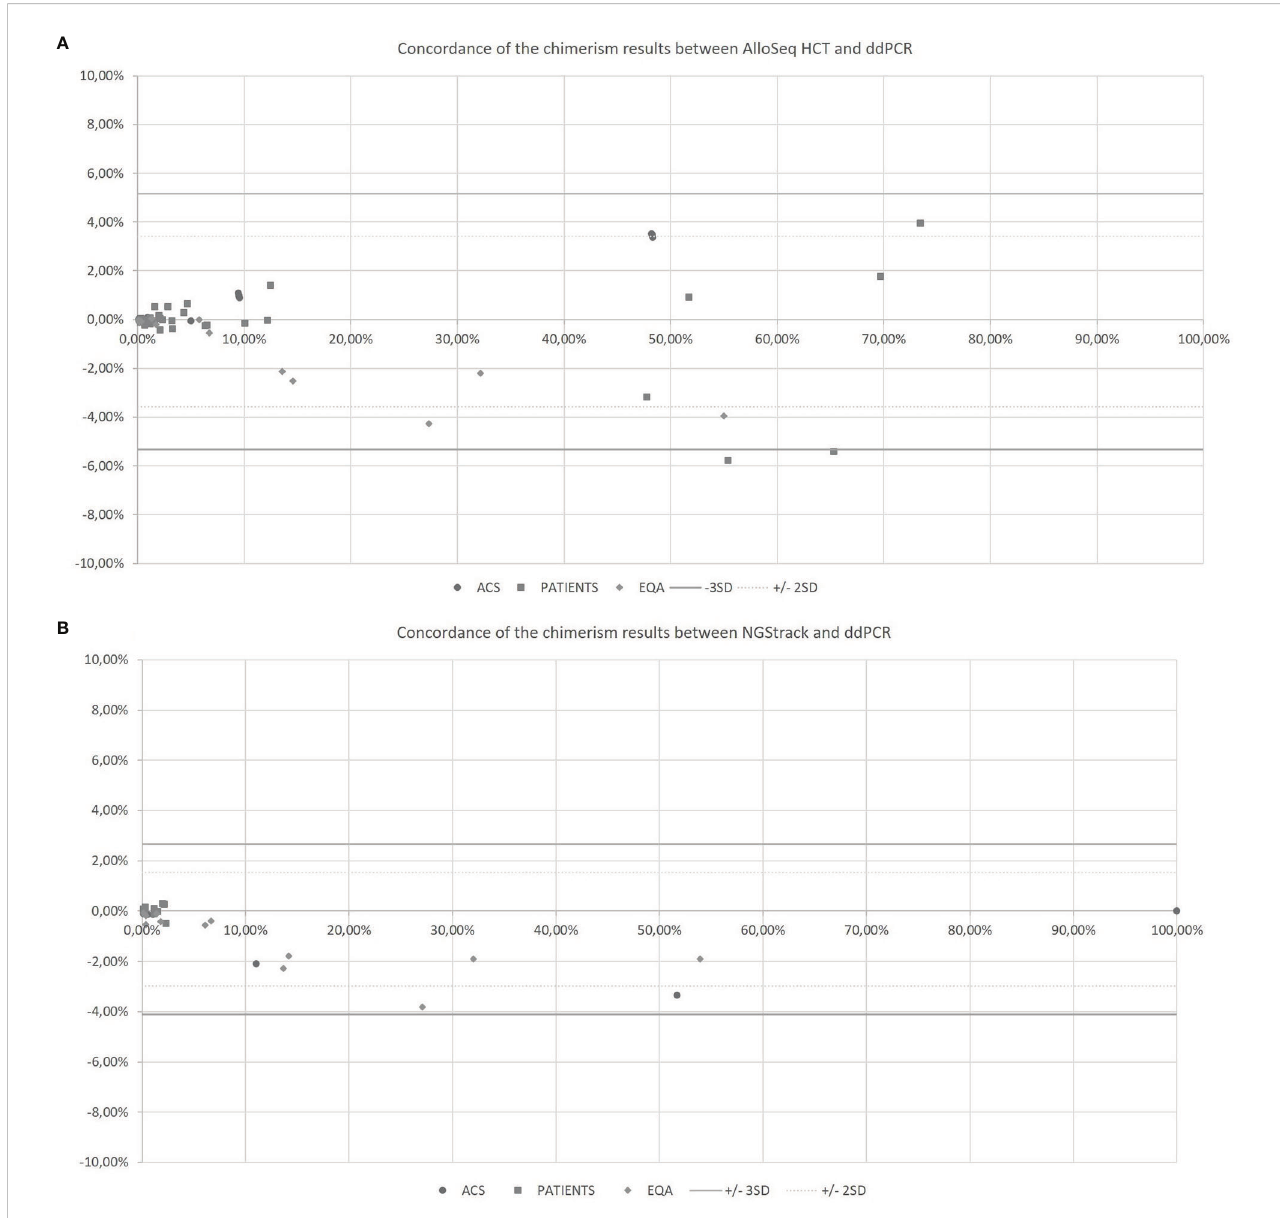
FIGURE 5 Concordance of the chimerism results between AlloSeq HCT and ddPCR (A) and between NGStrack and ddPCR (B) using the Bland-Altman plot. The Bland-Altmann plot includes the ± 2 standard deviation value (dotted lines) and ±3 standard deviation value (solid lines). ACS. Arti fi cial Chimeric Samples; EQA. External Quality